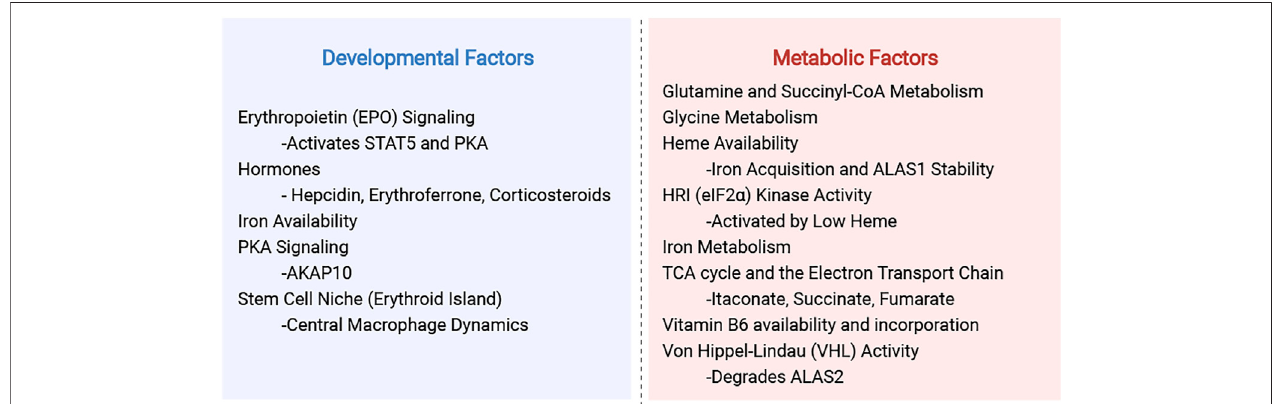
FIGURE 1 | Summary of developmental and metabolic factors that regulate heme synthesis.